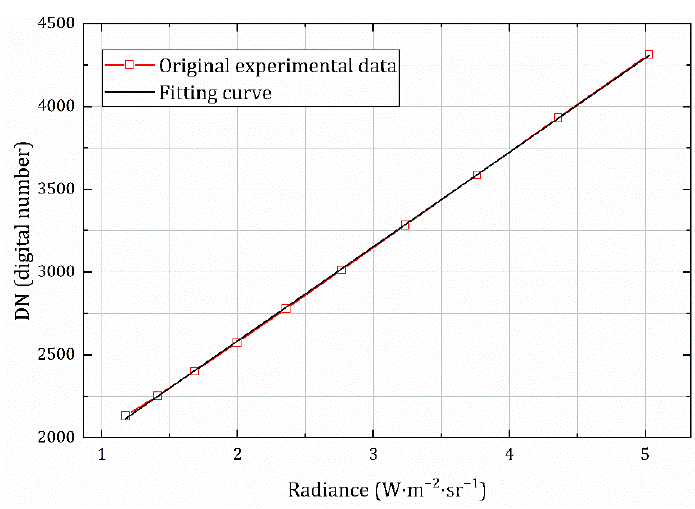
Figure 6. ( A ) Experimental setup for the calibration of the near-extended source (NES) blackbody. ( B ) Calibration experiment of the simulated baffle blackbody.